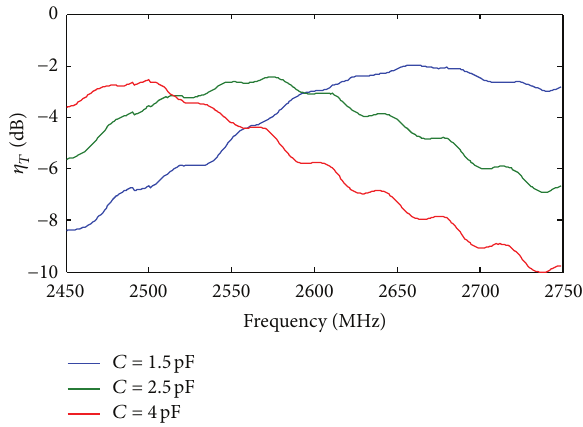
Figure 9: Measured total efficiency of the demonstrator in Figure 6.